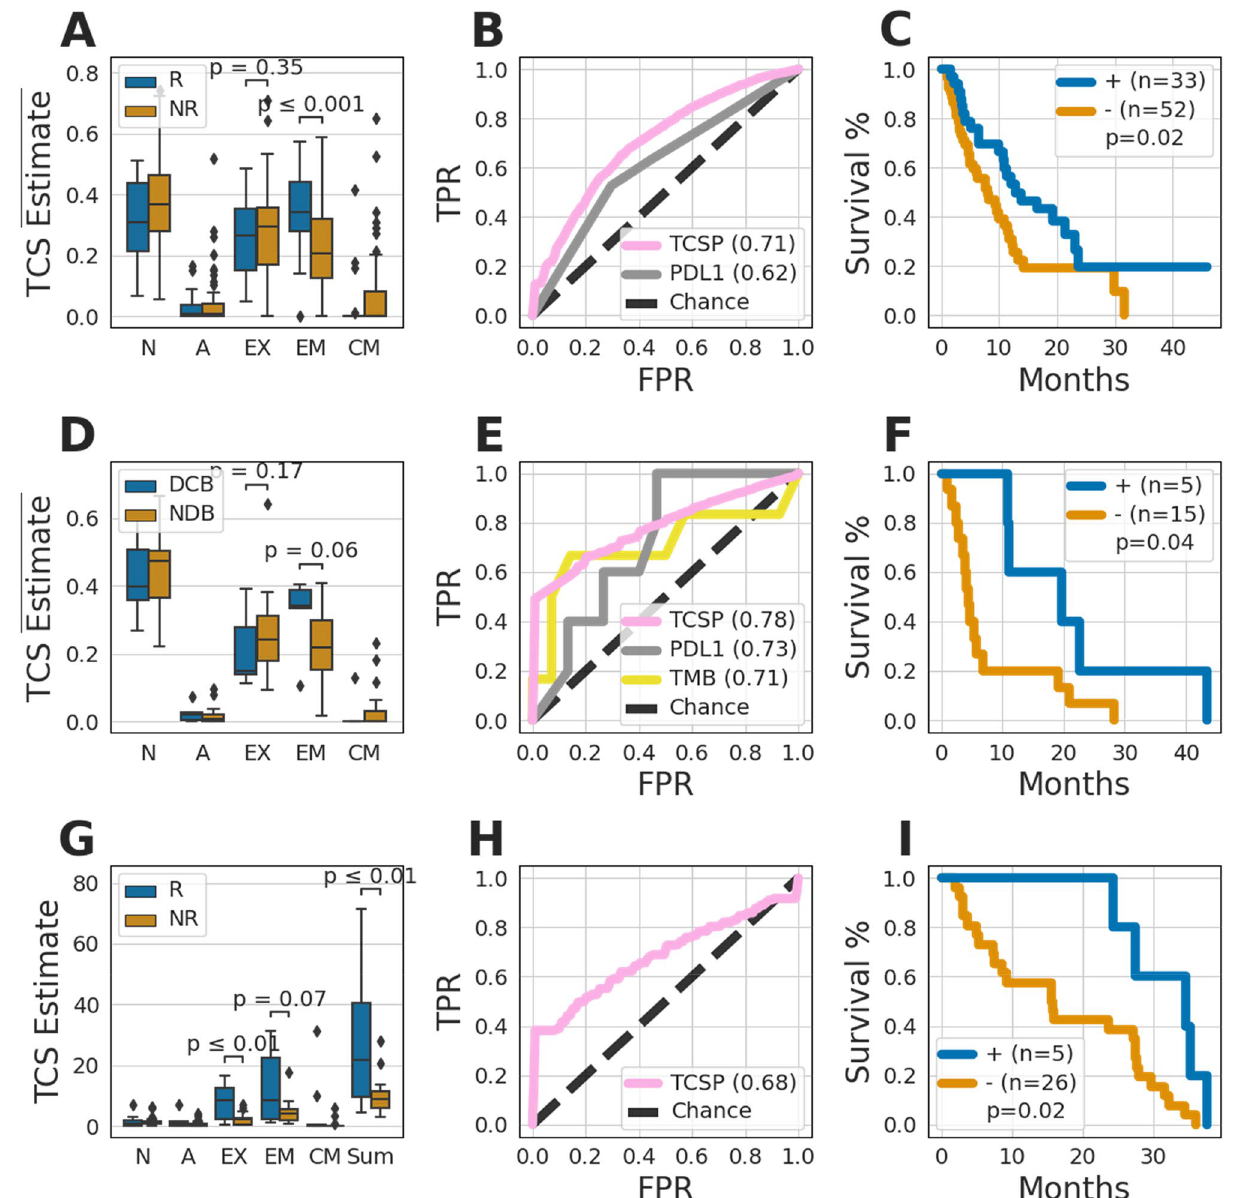
Figure 4. T Cell Subtype Profiling predicts anti-PD1 response. Cohorts of patients with recurrent and metastatic Head and Neck Squamous Cell Cancer (HNSCC, A – C ), recurrent and metastatic Non-small Cell Lung Cancer (NSCLC, D – F ), and recurrent and metastatic Melanoma ( G – I ) were explored. Boxplots ( A , D , G ) show the sum-normalized ( A , D ) or non-normalized ( G ) T Cell Subtype estimates grouped by response to anti-PD1 therapy in the respective indications. R responder; NR non-responder; DCB durable clinical benefit; NDB non-durable benefit; N naïve subtype; A activated subtype; EX exhausted subtype; EM effector memory subtype; CM central memory subtype; Sum Sum of all five subtypes. The receiver operator characteristic (ROC) curves ( B , E , H ) of a biomarker derived from TCS estimates (TCSP), and where available, PD-L1 IHC (PDL1), and tumor mutational burden (TMB) are shown for each respective indication. Chance is shown as a dotted black line, and the area under each ROC curve (AUC) is detailed in the legend. Kaplan–Meier plots ( C , F , I ) of overall survival of patients who were predicted by the TCSP biomarker to be responders (+) and non-responder (−) in each respective indication. The following number of samples were in each cohort: HNSCC ( I ), R = 22 and NR = 63; NSCLC ( D ), DCB = 6 and NDB = 15; Melanoma ( G ), R = 10 and NR = 21. Hypotheses in ( A , D , G ) were tested using the one-sided Mann–Whitney U test. The alternative hypotheses in ( A , D ) are that EM is higher in responders and EX is higher in non-responders. The alternative hypotheses in ( G ) are that EX, EM, and Sum are higher in responders. Hypotheses in ( C , F , I ) were tested using the log rank